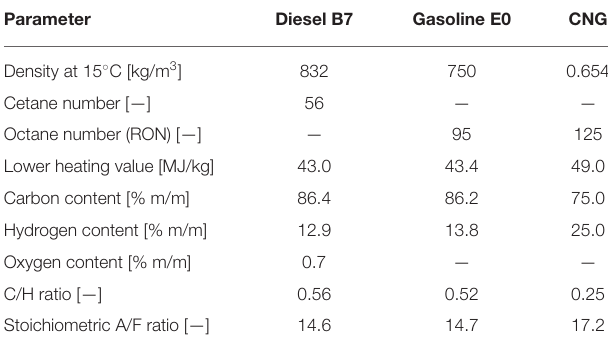
TABLE 4 | Typical properties of the fuels considered in this